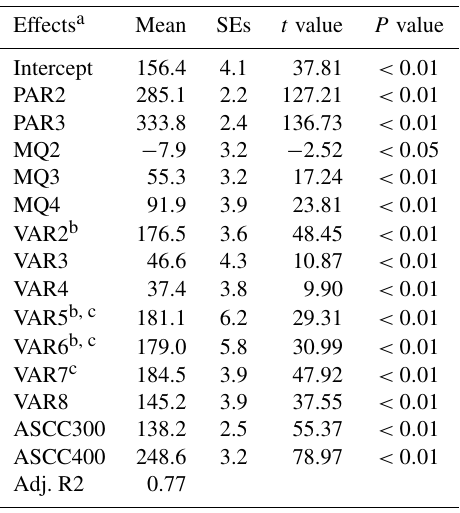
Table 3. Sources of variation for milk yield loss estimation included in the linear regression model with standard errors (SEs), t values, and P values.